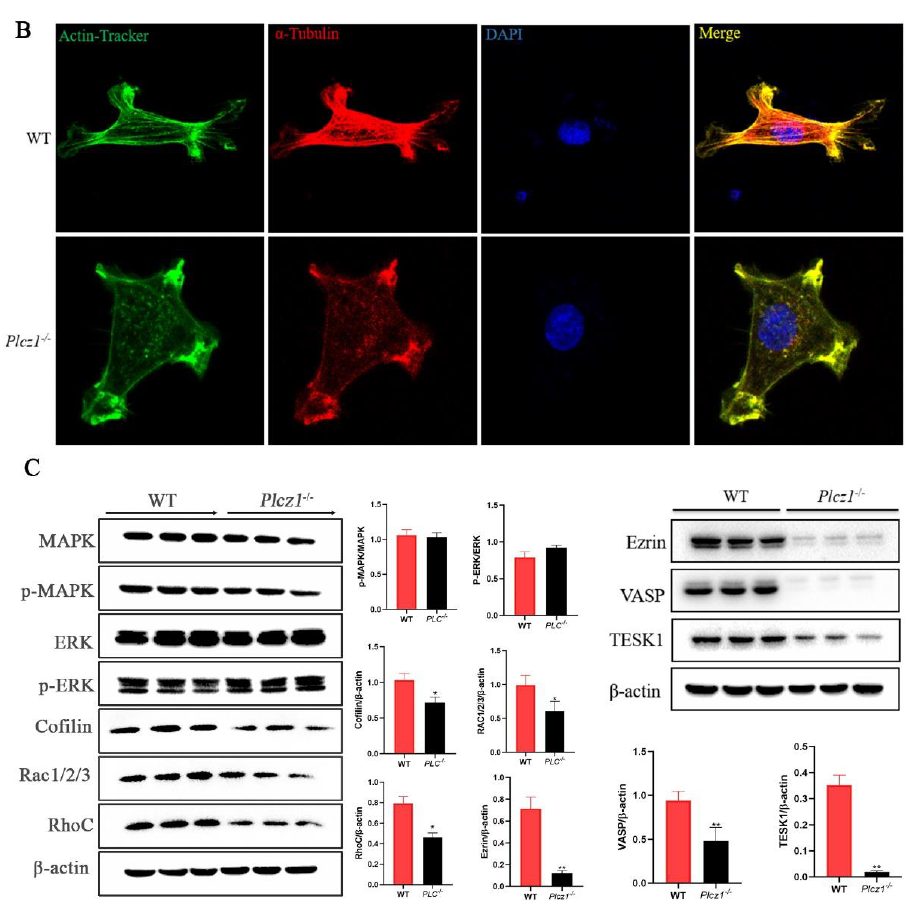
Figure 5. Effects of Plcz1 deletion on cytoskeleton in cauda epididymis and TM3 cells. ( A , B ) DAPI, α -microtubule antibodies, Rodin Ming-Phalloidin were used to stain cell nuclei, microtubules, and microfilaments, respectively. The cytoskeleton of TM3 cells was observed under the confocal laser microscope (Scale bar = 10 µ m). ( C ) The effect of Plcz1 knockdown on the expression of cytoskeletal motor proteins (chronophilin, cofilin, rac1/2/3 and RhoC) in TM3 cells (* p < 0.05, ** p <